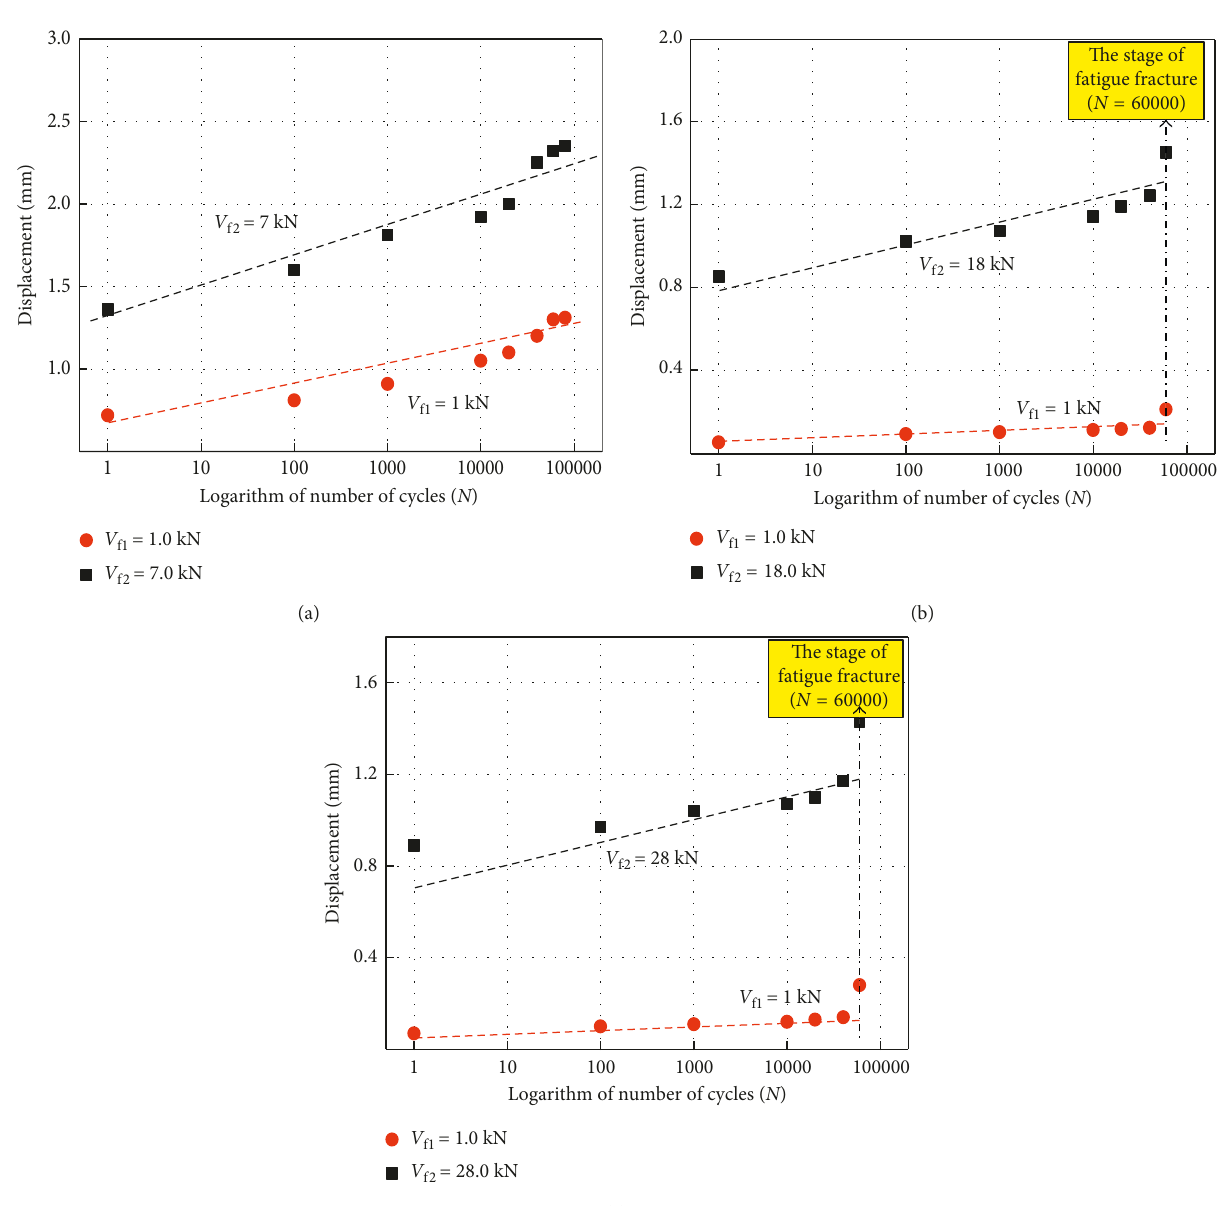
Figure 8: Incremental displacement against the number of fatigue cycles: (a) D12-F; (b) D20-F; (c)